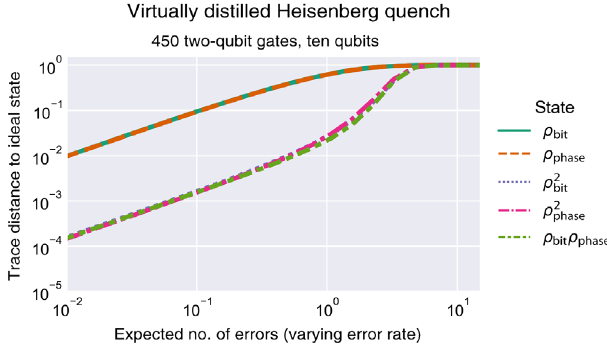
FIG. 13. The error in the unmitigated noisy states, and the states accessed by virtual distillation, for the same ten-qubit Heisenberg evolution under two different noise models. We consider a bit-flip error model ( ρ , teal curve) and phase-flip error model ( ρ bit orange dashed curve). We show the error for virtual distillation applied in the usual way to two identical copies of each noisy state ( ρ 2 and ρ 2 , purple dotted curve and pink dashed bit phase